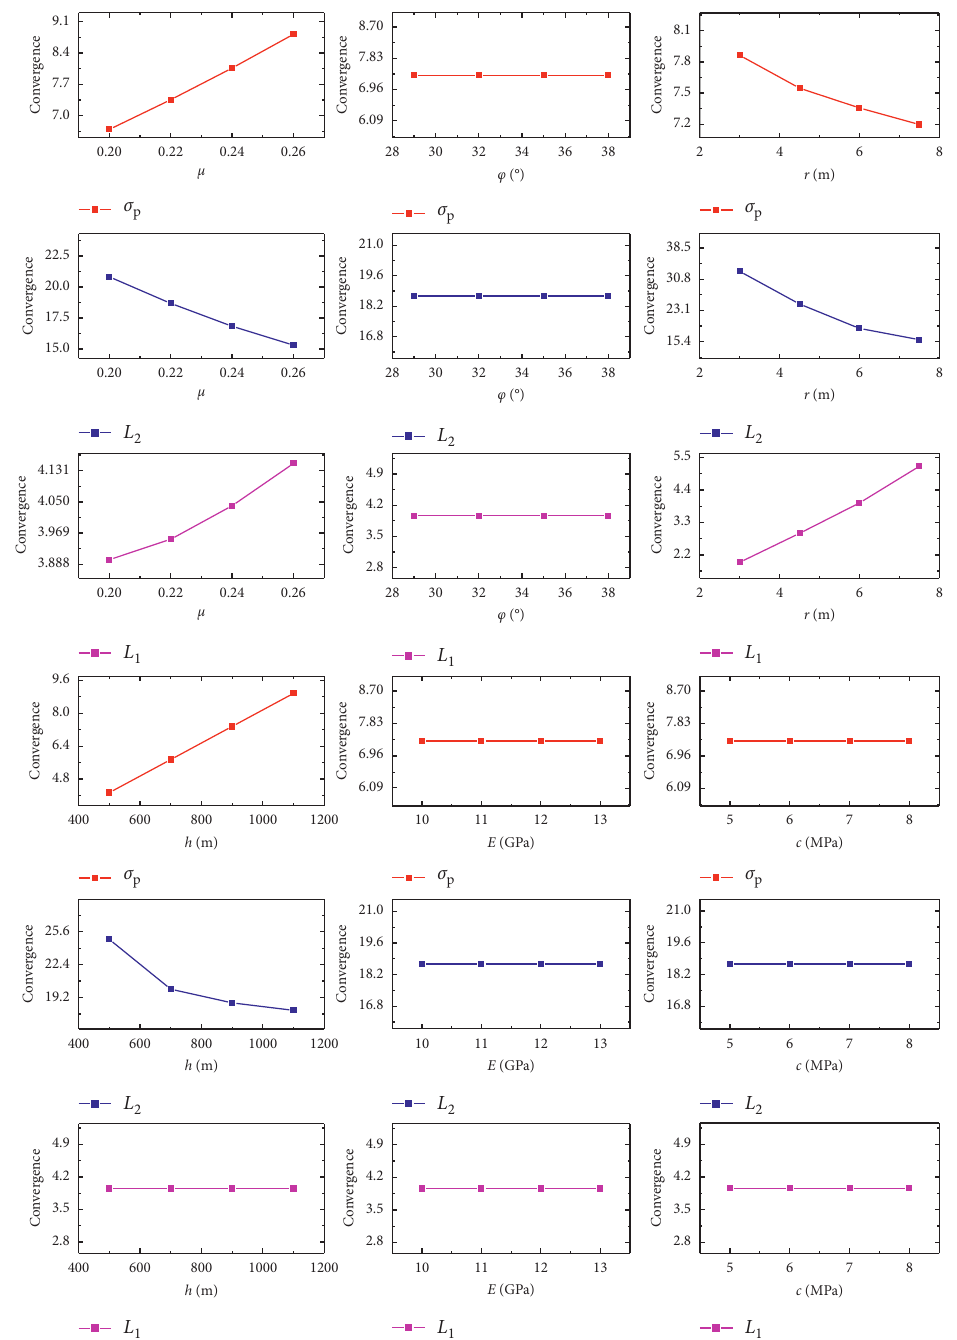
Figure 5: Variation curves of peak stress, distressed zone, and stress concentration zone by the change of single